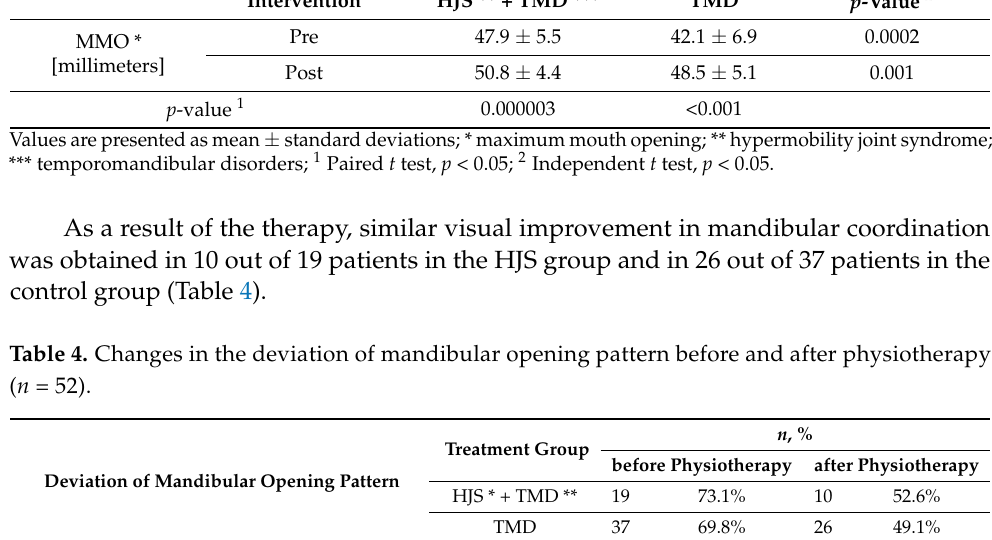
Deviation of Mandibular Opening Pattern